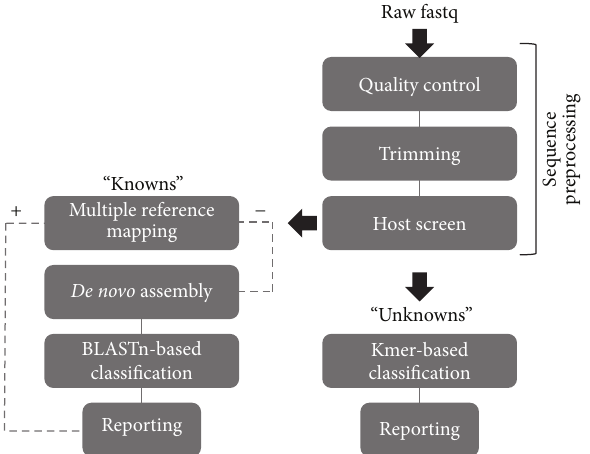
Figure 2: Metagenomic pipeline constructed to analyse the two datasets. Following shared sequence preprocessing steps, QC passed sequences from the known viral sample entered reference-based mapping with all unmapped reads de novo assembled then classified, whilst the nonhuman model sample entered a kmer-based classifi- cation